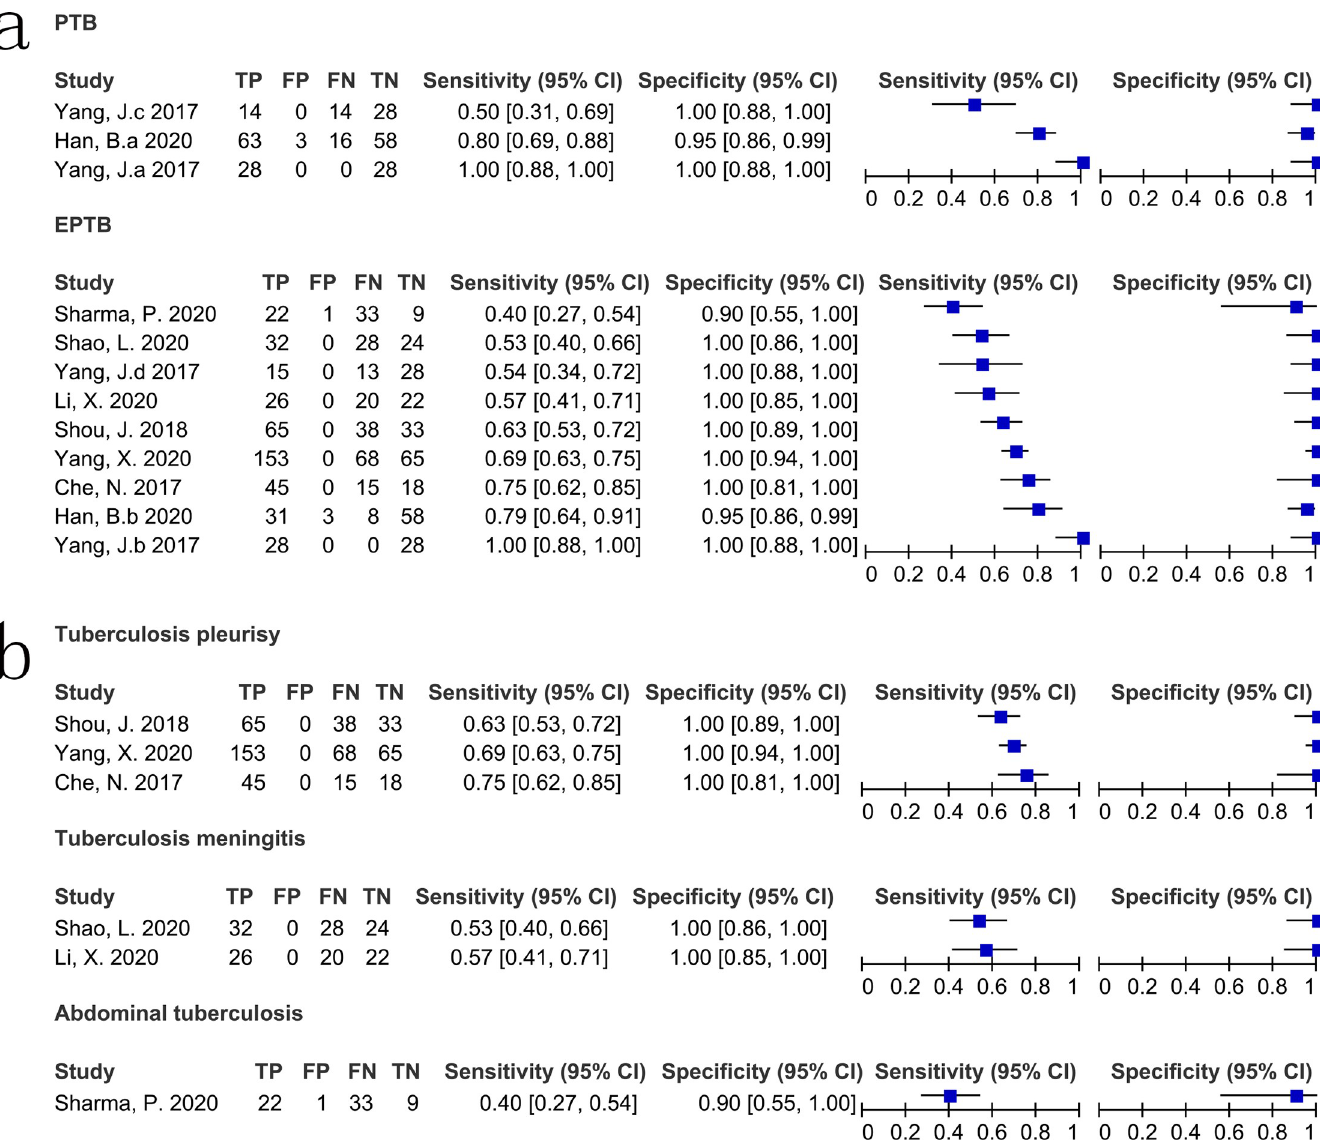
Fig 5. Forest plot for the sensitivity and specificity of cell free DNA for the diagnosis of different types of tuberculosis compared with a composite reference standard. a) pulmonary tuberculosis and extrapulmonary tuberculosis. b) different types of extrapulmonary tuberculosis. PTB, pulmonary tuberculosis; EPTB, extrapulmonary